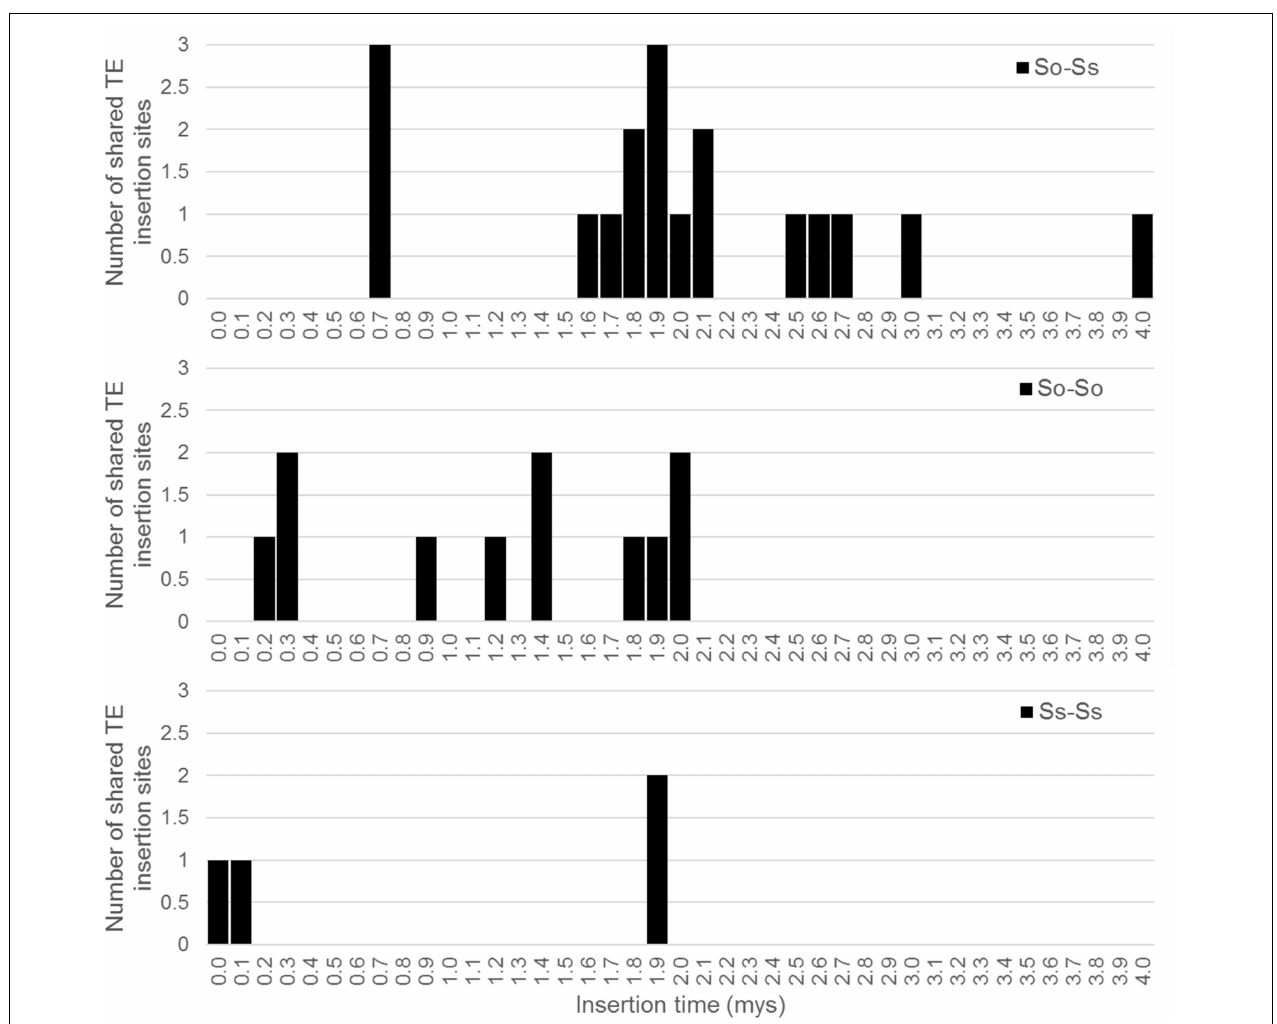
FIGURE 7 | Insertion times of LTR junction markers shared between Saccharum BACs. The X axis represents the insertion time (mys) and the Y axis represents the number of shared LTR junction markers. The insertion time was calculated based on substitution rate of 1.3 × 10 − 8 per site per year (Ma and Bennetzen,